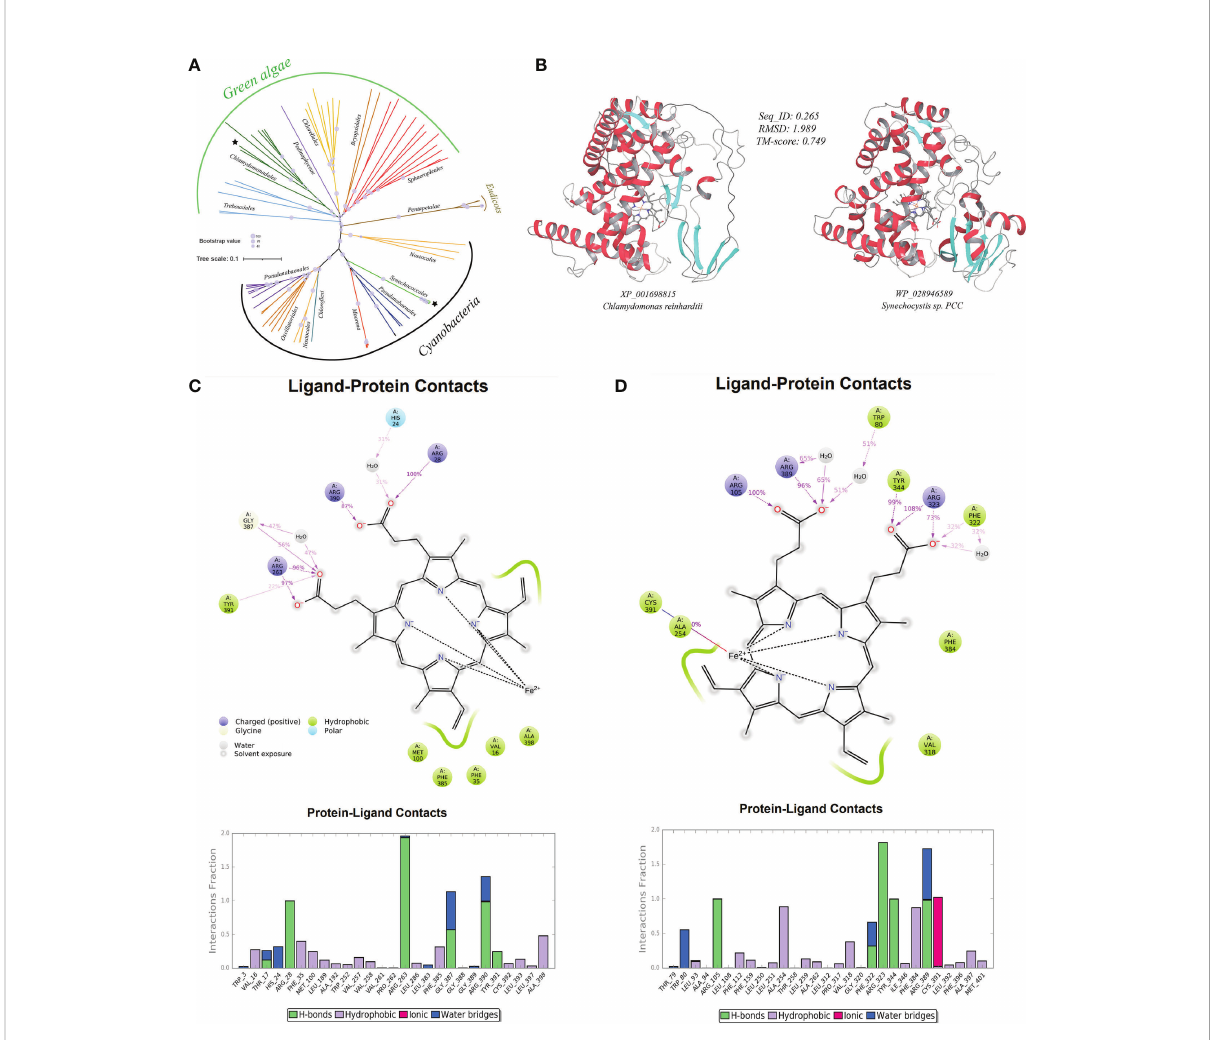
FIGURE 5 A case-study of microbe-originated plant cytochrome P450 and its donor protein. (A) Phylogenetic tree of the organic pollutant catabolism protein cytochrome P450 constructed by PhyML program with the Maximum Likelihood (ML) method and 1,000 bootstrap replicates (with bootstrap values shown by size of symbols); (B) structure perdition (deep-learning-driven) and comparison of representative recipient plant cytochrome P450 (left, Chlamydomonas reinhardtii : XP_001698815) and its putative microbial donor (right, Synechocystis sp. PCC: WP_028946589); (C) ligand-protein simulation diagram (5 ns classical molecular dynamics) of cytochrome P450 from Chlamydomonas reinhardtii (XP_001698815) showing key residues in proteins interacting with the hame prothetic group (ligand). Interactions that occur more than 30.0% of the simulation time in the selected trajectory (0.0 through 5.0 ns), are shown; (D) ligand-protein simulation diagram (5 ns classical molecular dynamics) of the cytochrome P450 from donor Synechocystis sp. PCC (WP_028946589) showing key residues in proteins interacting with the hame prothetic group (ligand) for